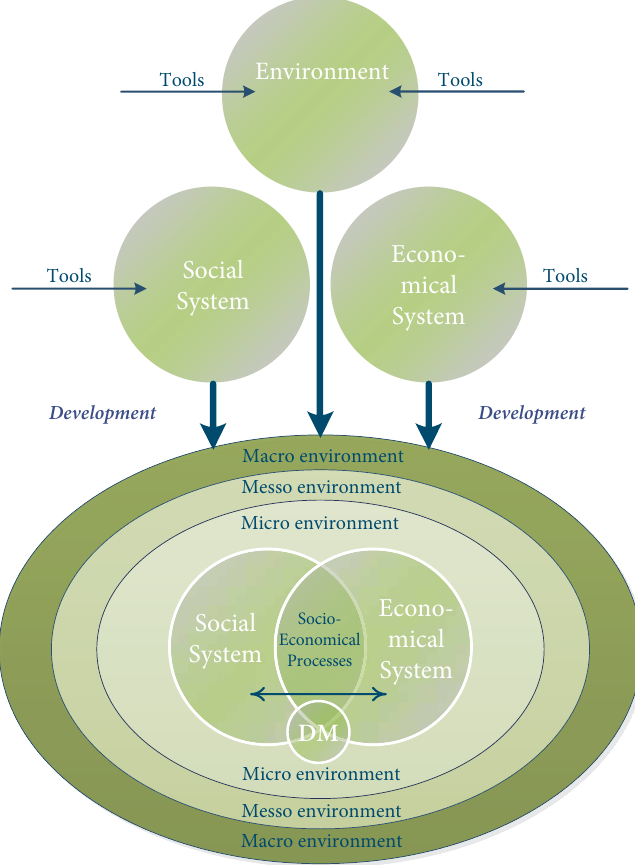
Fig. 1. SEA increasing integration of environmental, social and economic